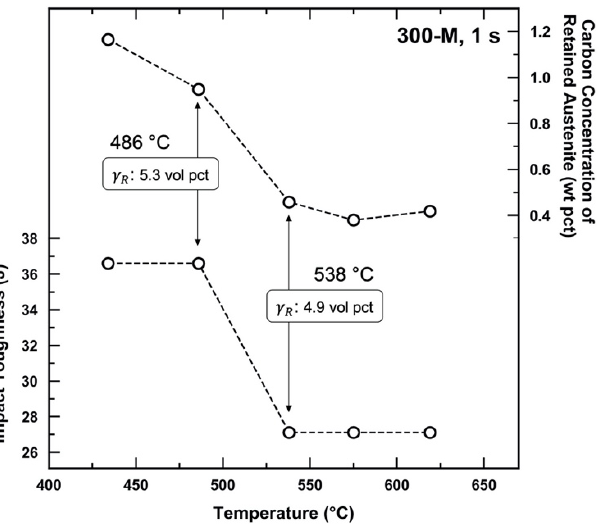
Figure 6. Impact energy and carbon concentration of retained austenite shown as a function of tempering temperature for the 300-M, 1 s conditions. Tempering temperatures associated with the appearance of TME are highlighted, and the associated retained austenite contents are shown.